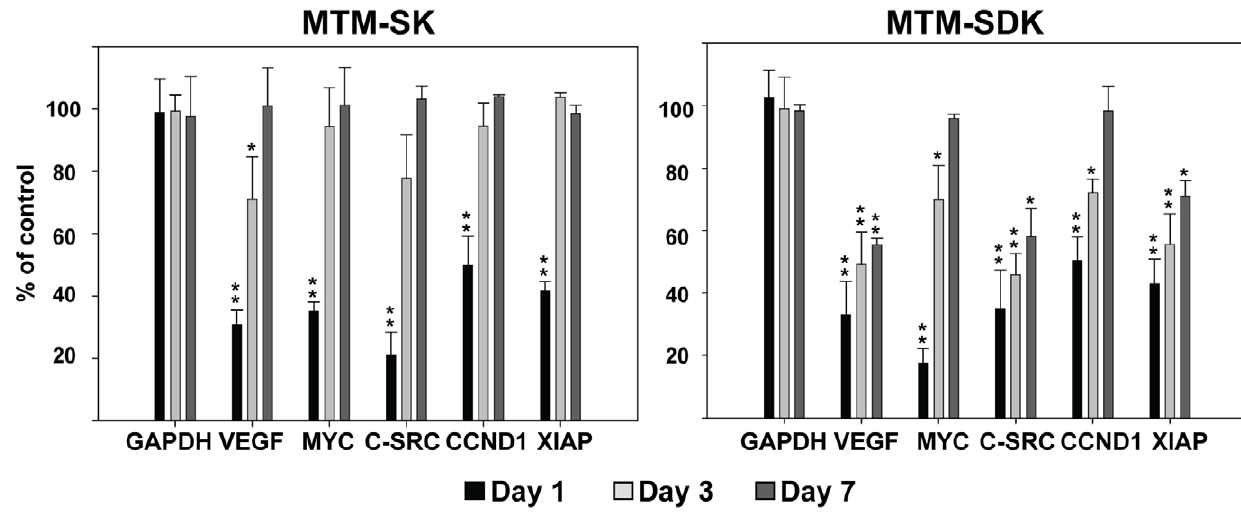
Figure 4. Inhibition of Sp dependent transcription by MTM-SDK and MTM-SK in tumor xenografts. Mice (n=4/group) with subcutaneous tumors were treated with a single IV injection of MTM-SDK, MTM-SK or sterile saline solution. Doses of MTM-SK and MTM-SDK were 8 mg/kg and 1.2 mg/kg, respectively. Tumors were harvested 1, 3 and 7 days after drug injection. Gene expression was assessed by qRT-PCR. Data represent mean 6 SD of the transcript level normalized to B2M RNA and are presented as percentage of expression compared to control mice receiving sterile saline solution. *, P , 0.01; **, P , 0.001.